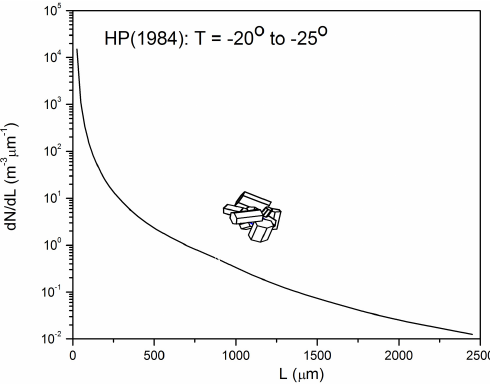
Fig. 22. The ice cloud particle size distribution of HP (1984): T =− 20 ◦ to − 25 ◦ (Fu, 1996). Also shown is the assumed ice crys- tal aggregate particle